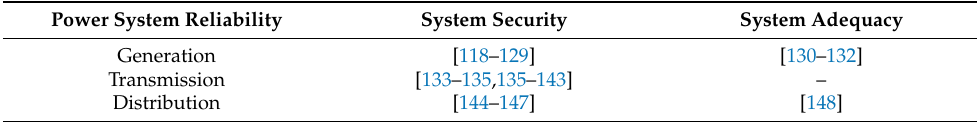
Table 3. HLs of power